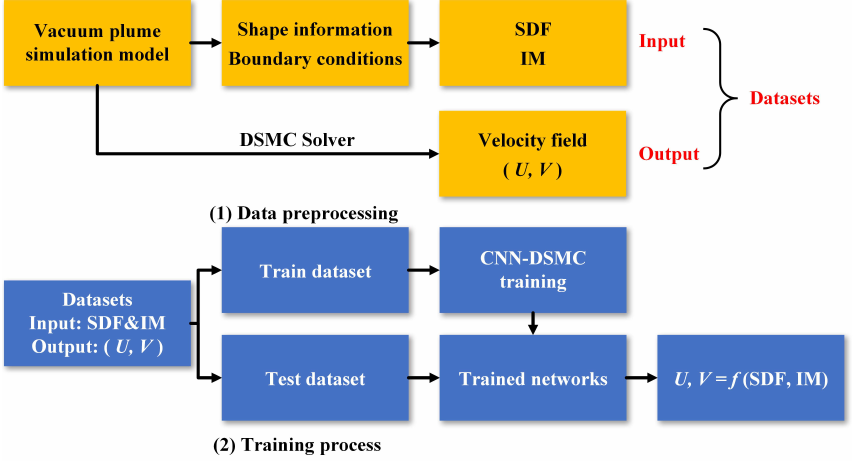
Figure 18. Data preprocessing and training processes of CNN-DSMC method